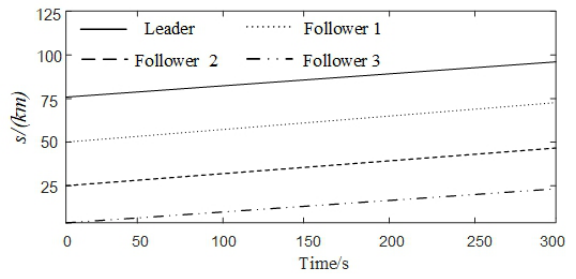
Fig. 4. Position of each train under finite-time